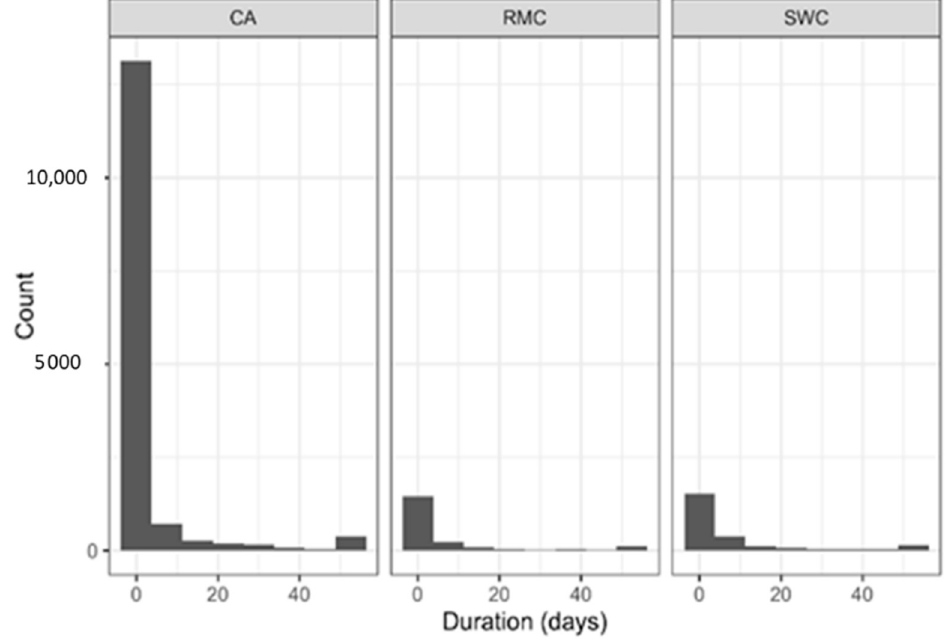
Figure 1. The total number of fires of different durations in the three Geographic Area Coordination Centers (GACCs) during the three ‐ year analysis period from 2016 to 2018.